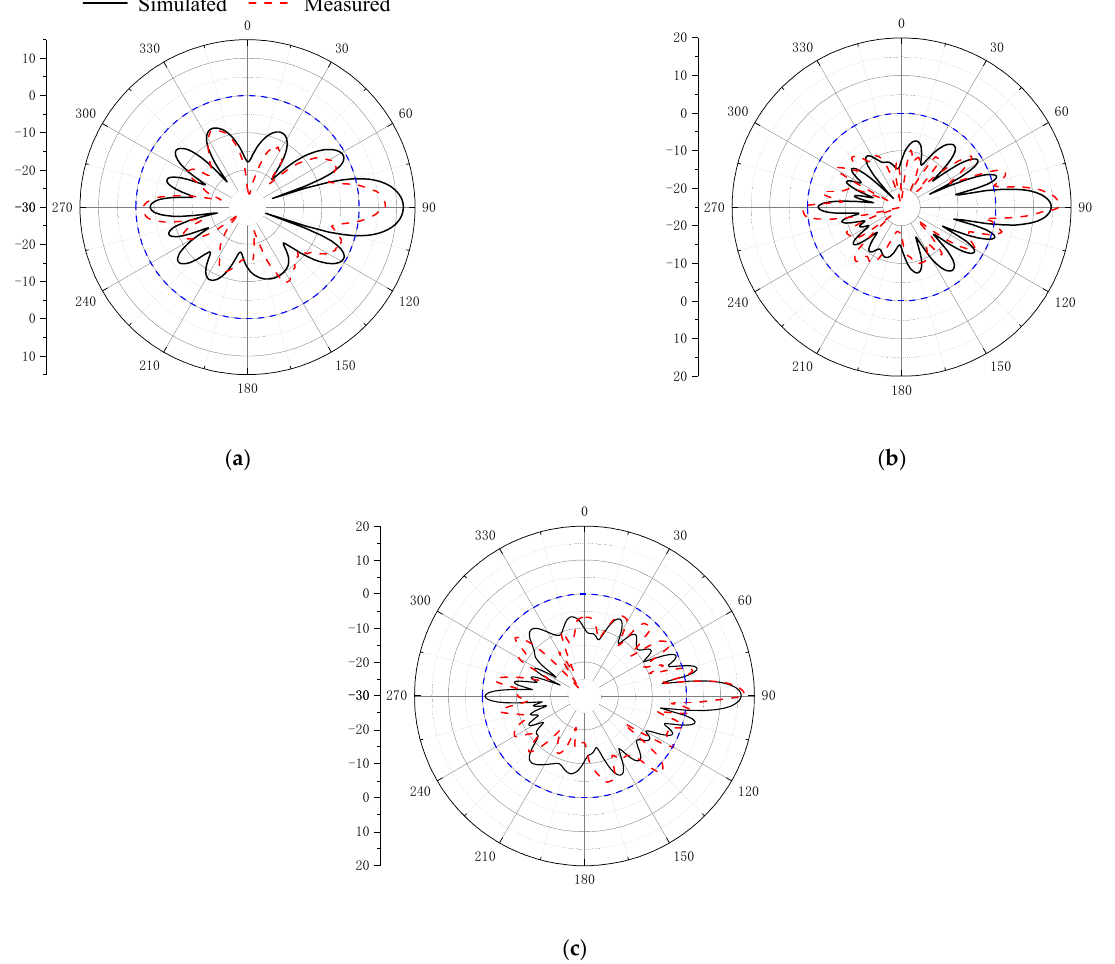
Table 6. Narrow beam Vivaldi 8-element array E-plane pattern main lobe width.